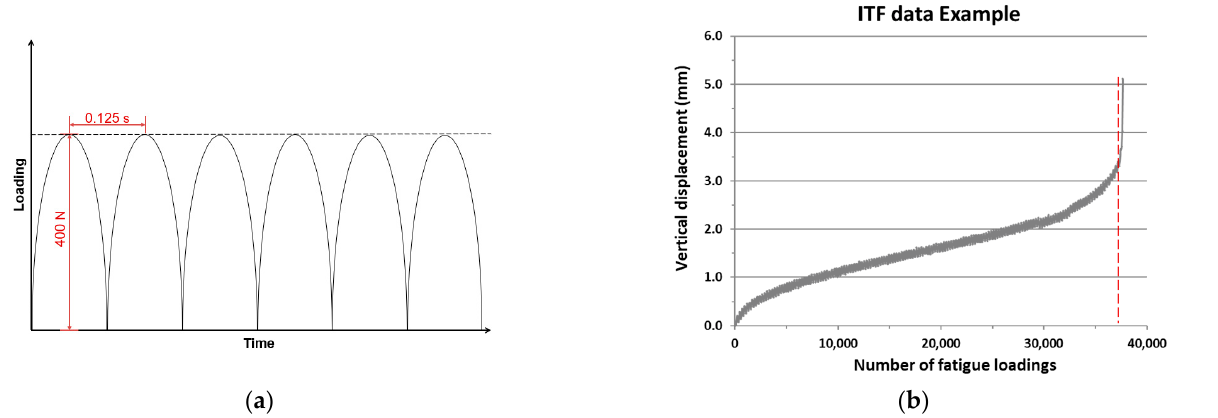
Figure 6. The ITF test: ( a ) the loading configuration schematic and ( b ) ITF test data example, where the red dashed line indicates the fatigue life.